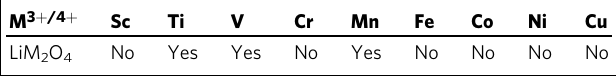
Table 4 LiM 2 O 4 oxides crystallizing in the spinel